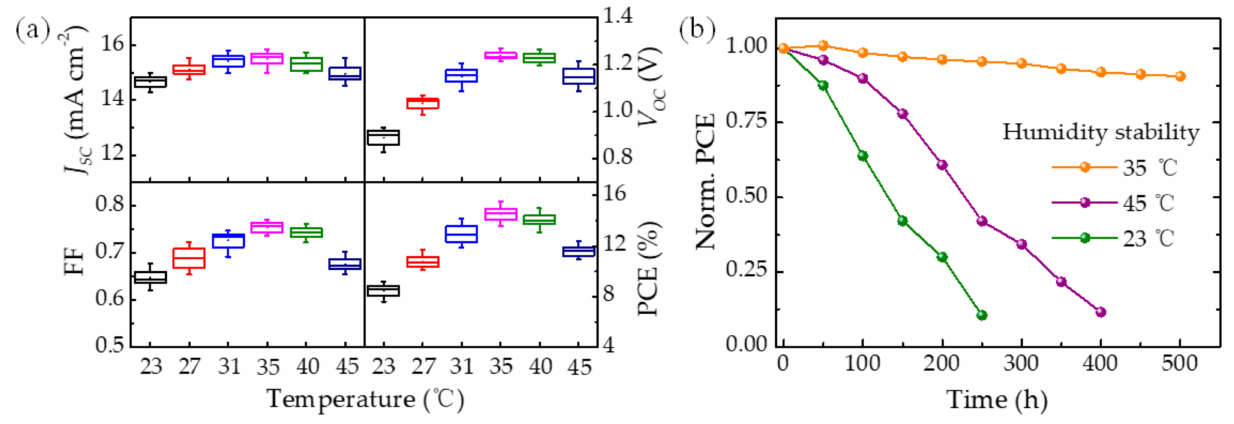
Figure 6. ( a ) Statistics on the photovoltaic parameters of perovskite solar cells. ( b ) Evolution of power conversion efficiency of the 23 ◦ C, 35 ◦ C, and 45 ◦ C PSCs without encapsulation. The devices were stored under air ambient atmosphere with controlled relative humidity (R.H., 15 ± 3%).